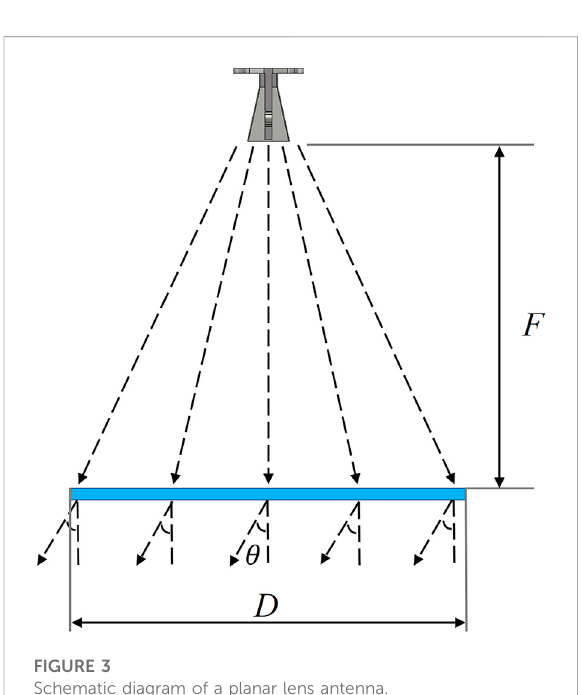
FIGURE 3 Schematic diagram of a planar lens